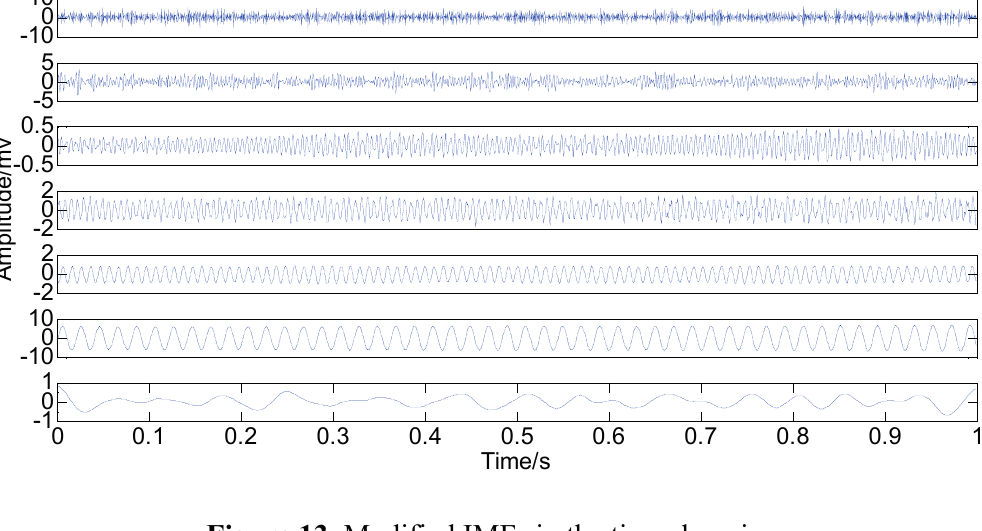
Figure 13. Modified IMFs in the time-domain.